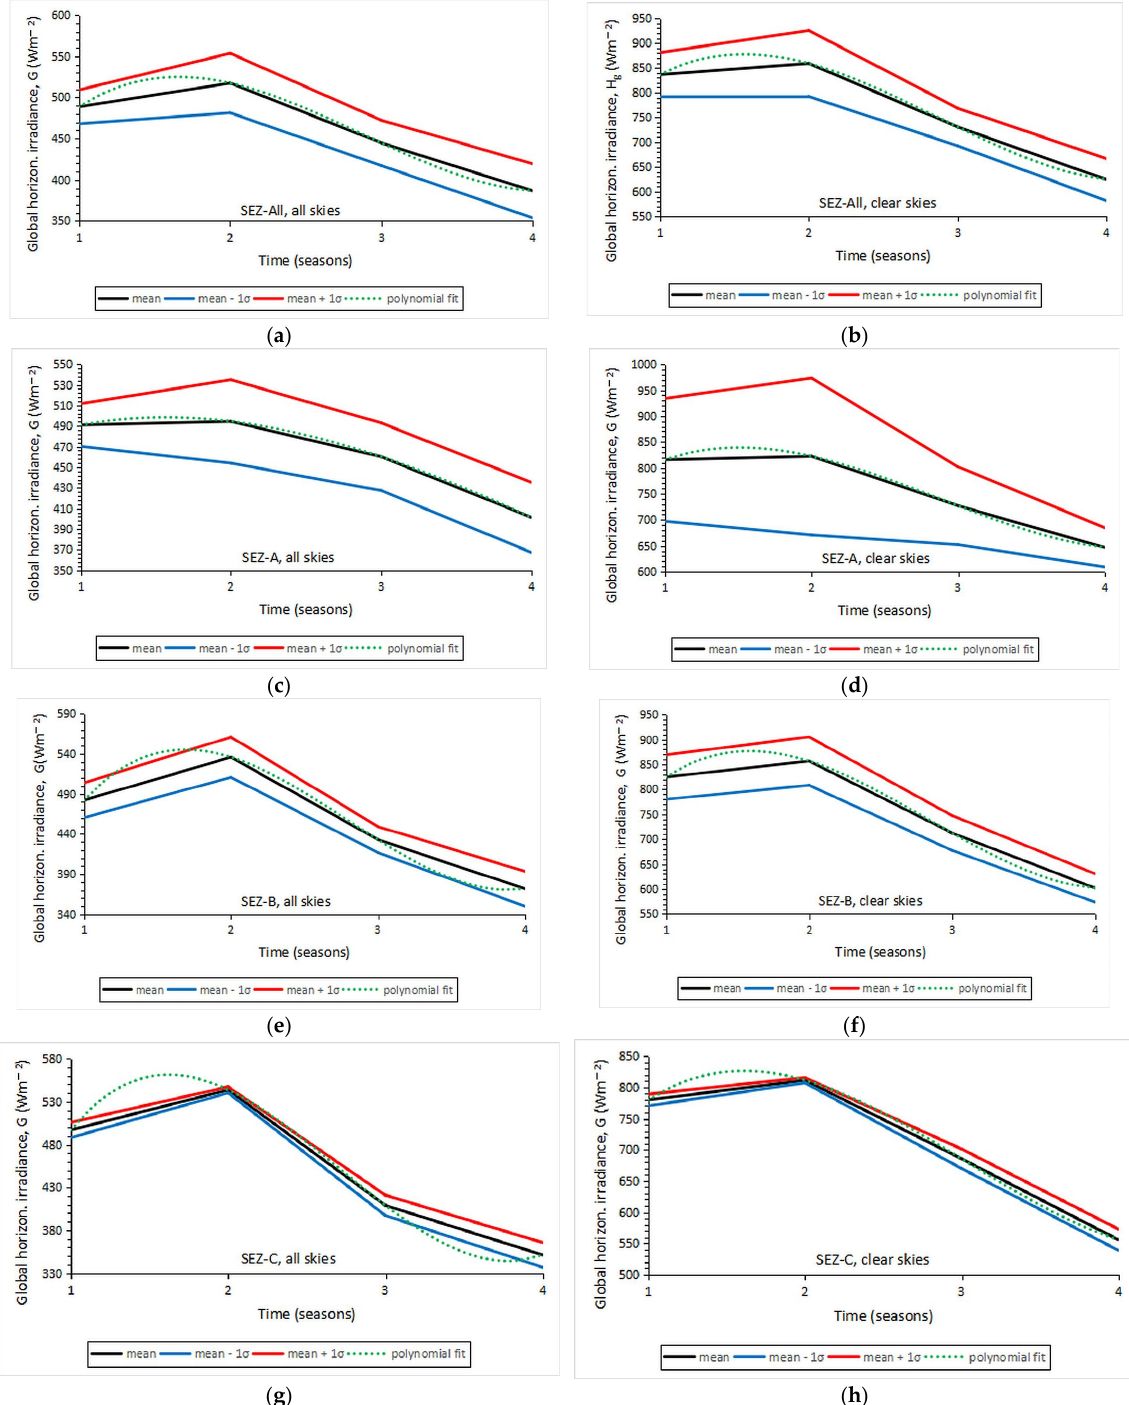
Figure 5. Seasonal mean G values under all—(left panels) and clear—(right panels) sky conditions across Saudi Arabia in the period 2013–2021 ( a – h ). The first row indicates the SEZ-All case, the second is SEZ-A, the third is SEZ-B, and the last row is SEZ-C. The G values are averages across the sites belonging to each SEZ over the studied period. The black lines represent the means; the red and blue lines are the upper and lower limits of the ± 1 σ band around the means, respectively. The green dotted lines are 3rd-order polynomial fits to the mean curves. The numbers 1, 2, 3, and 4 on the x -axis correspond to the seasons spring, summer, autumn, and winter, respectively. All plots were derived with the MICROSOFT’s Excel 2021